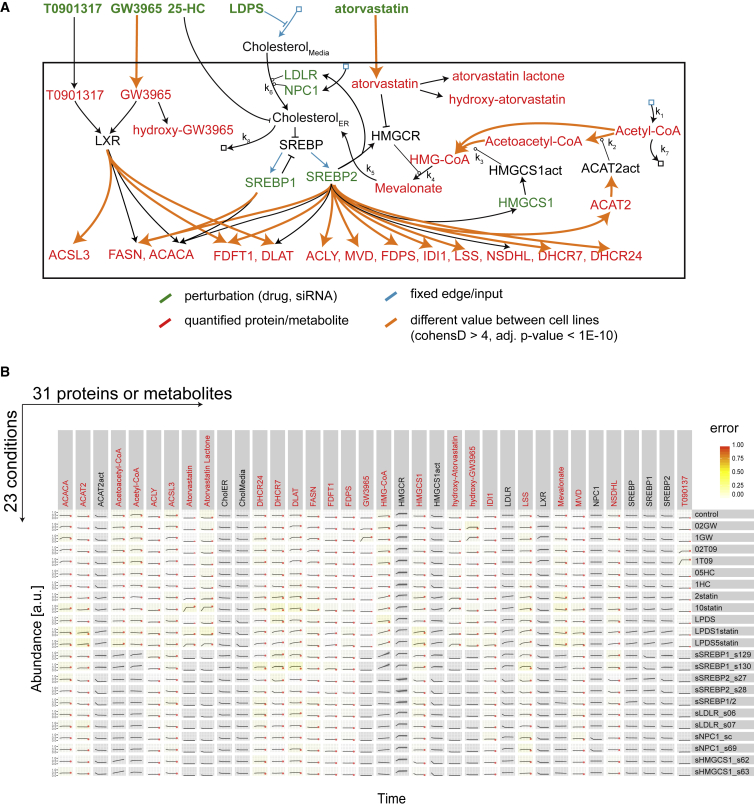
Logic-Based ODE Model of Cellular Cholesterol Regulation(A) Model for cellular cholesterol regulation indicating positive (arrows) and inhibitory (inverted T) interactions between nodes (proteins, metabolites, or protein activities). Metabolic reactions are labeled with k1-7. Edges that show a significant different strength between cell lines are depicted in orange (for further details, see the STAR Methods; see also Figure S6).(B) Overview plot showing the 100 trained models for Huh7 cells (shaded area show the 0.1, 0.25, 0.75, and 0.9 quantile prediction) and the experimental result (red dot indicating quantified signal in the molecules labeled in red font).